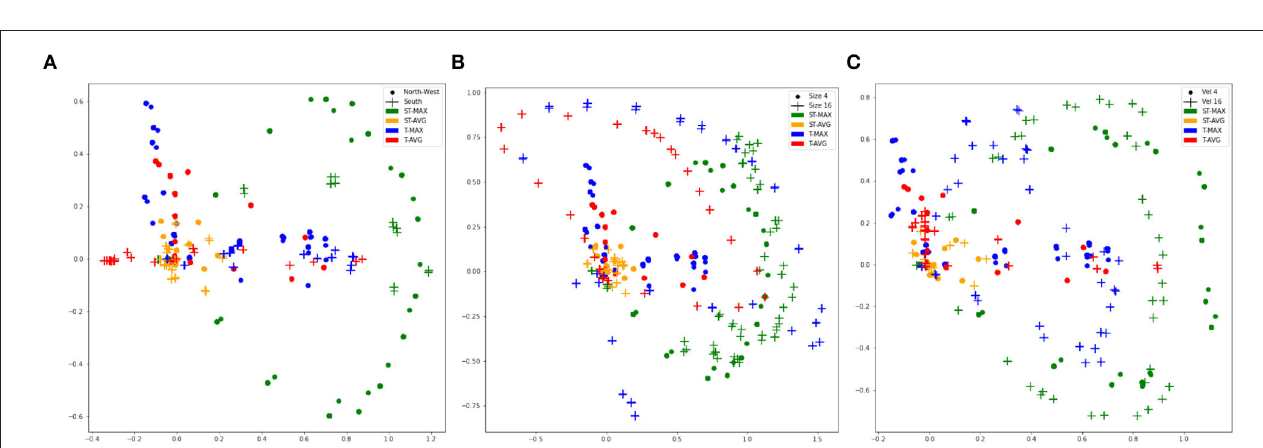
FIGURE 4 | Example of pooling: (A) Spatio-temporal Max Pool (ST-MAX= MP V (T-MAX= MP V